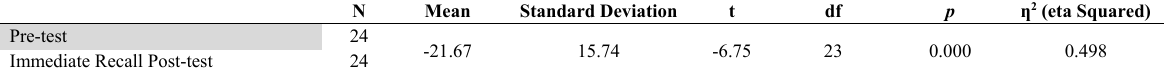
Results of the Paired Samples Test between Pre-test and Immediate Recall